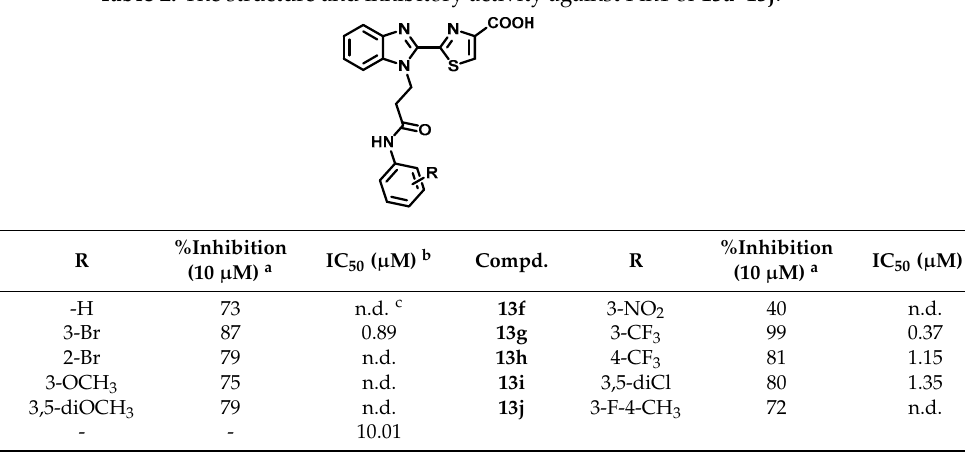
Table 2. The structure and inhibitory activity against Pin1 of 13a–13j . a Values are means of triple independent experiments. b All results represent the mean of duplicate experiments. c not determined.